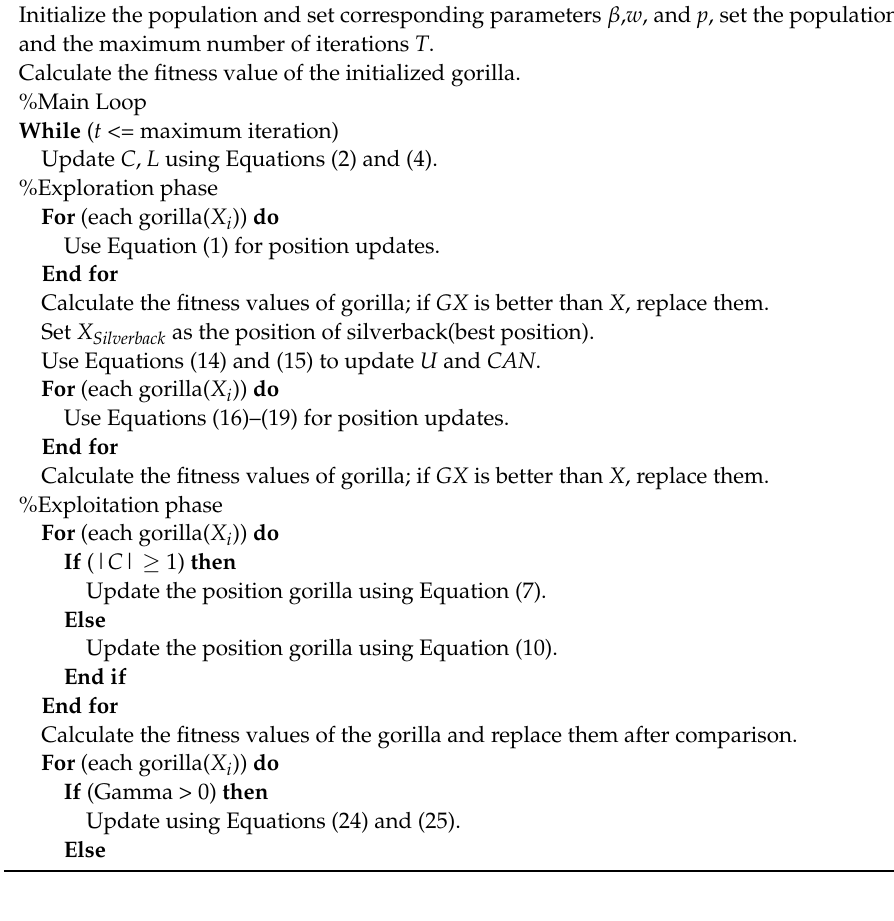
Algorithm 1: Pseudocode of MGTO